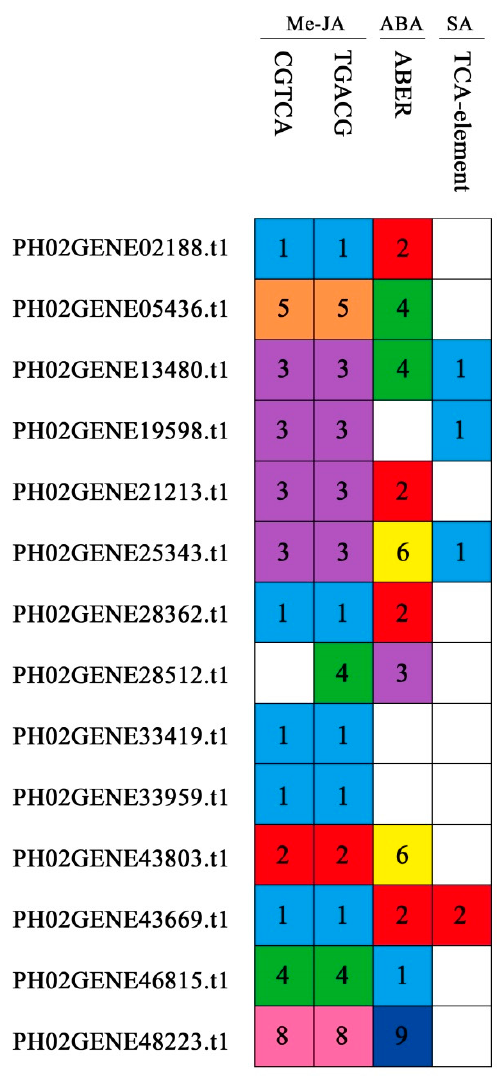
Figure 8. cis -Acting elements related to ABA, MeJA, and SA in the promoter regions of PeUBPs. The colored blocks containing numbers represent the numbers of cis -element in PeUBPs.